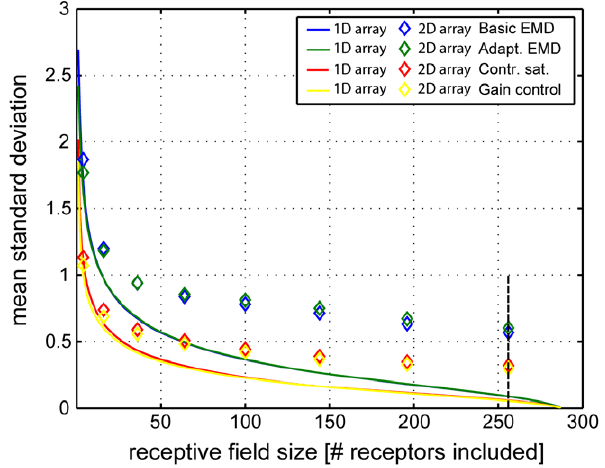
linearities and gain control in the input lines (Fig. 1C&D) show a